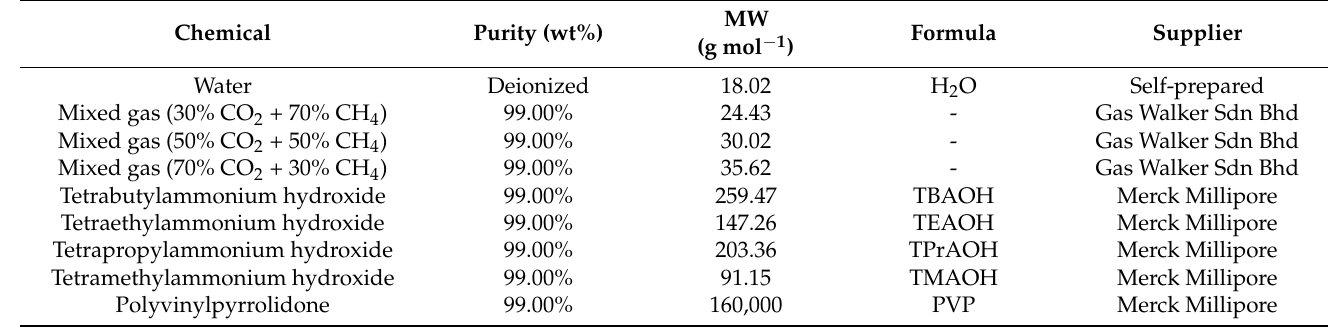
Table 1. Details of chemicals